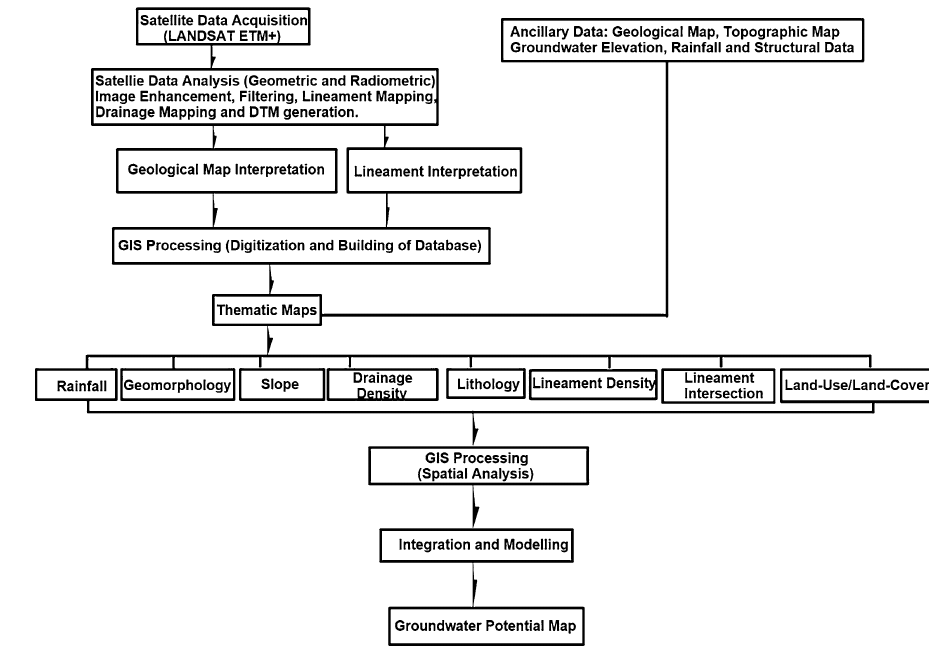
Fig. 3 Flow chart of